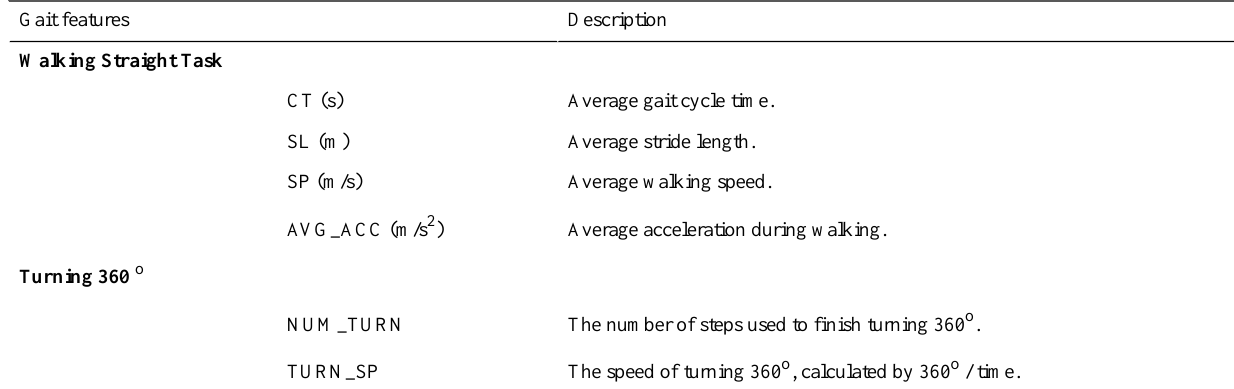
Table 3. Extracted gait motion